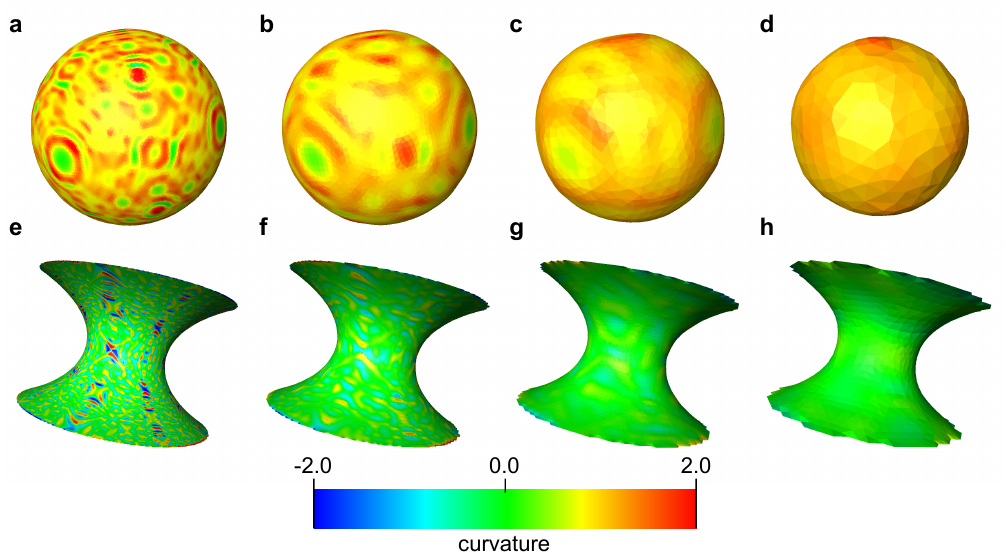
Figure 3. The smoothed surfaces extracted from the voxelized images for different grid sizes. The sphere surface with ( a ) ∆ = 0.025, ( b ) ∆ = 0.05, ( c ) ∆ = 0.1 and ( d ) ∆ = 0.2. The catenoid surface with ( e ) ∆ = 0.025, ( f ) ∆ = 0.05, ( g ) ∆ = 0.1 and ( h ) ∆ = 0.2. These surfaces were obtained with 600 iterations of Laplacian smoothing and are colored by the computed mean